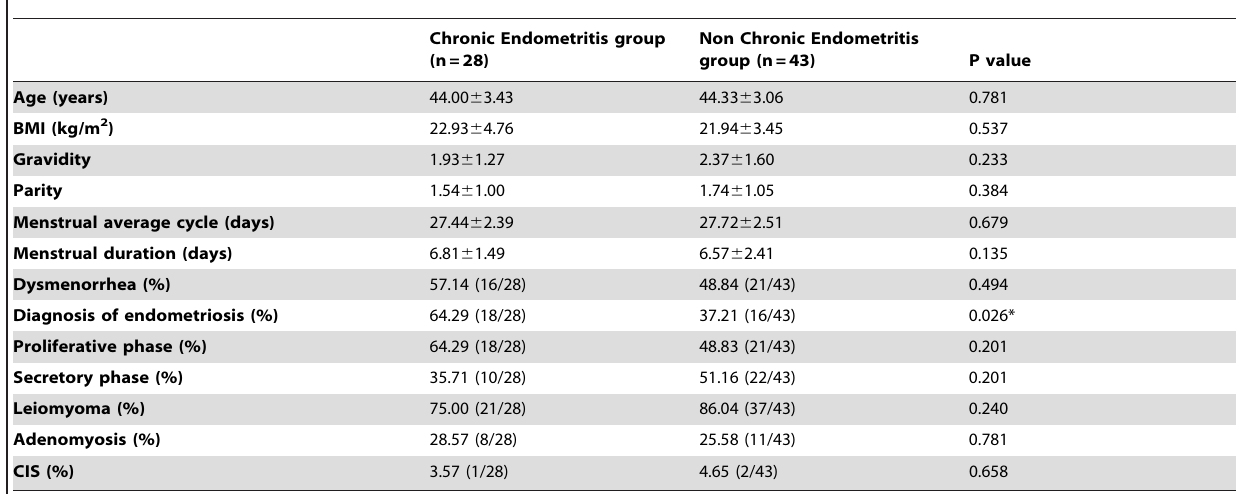
Table 3. Clinical characteristics and pathological diagnoses of uterus (chronic endometritis and non-chronic endometritis groups).